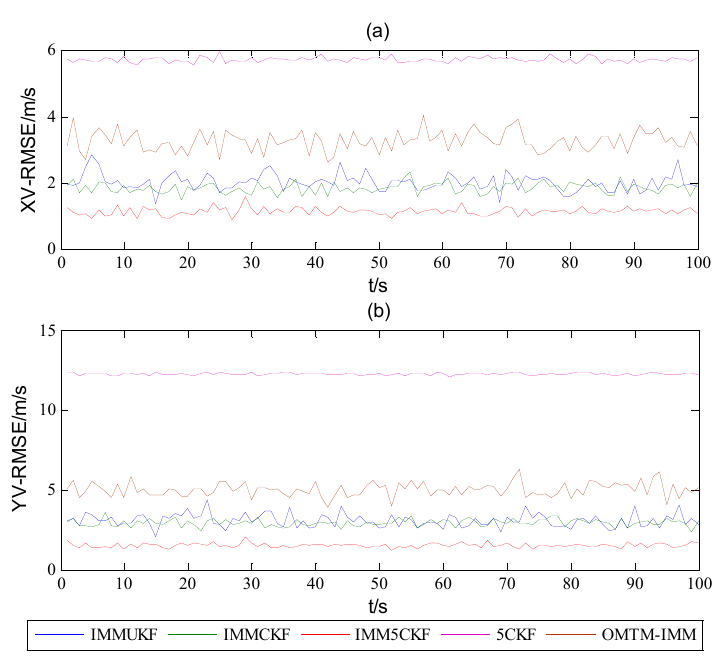
Figure 4. RMSEs of ( a ) X-velocity and ( b ) Y-velocity.